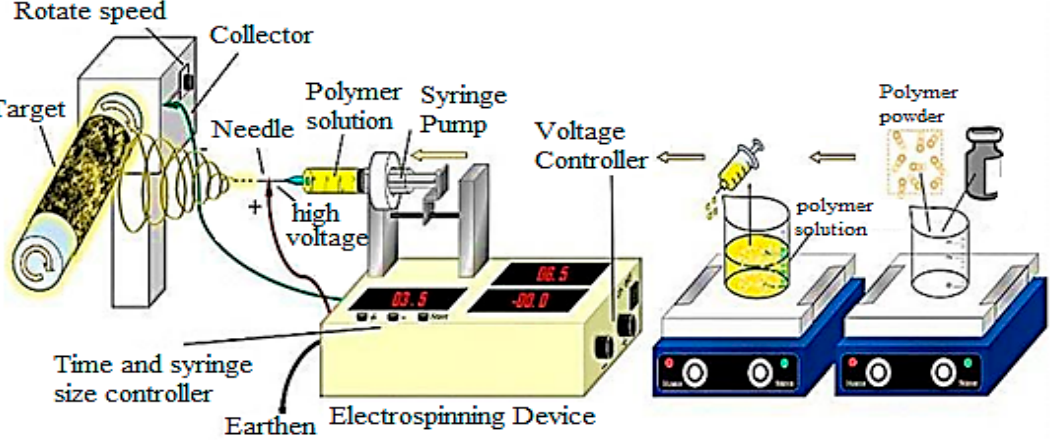
Figure 4. The set-up of electrospinning technique (taken from